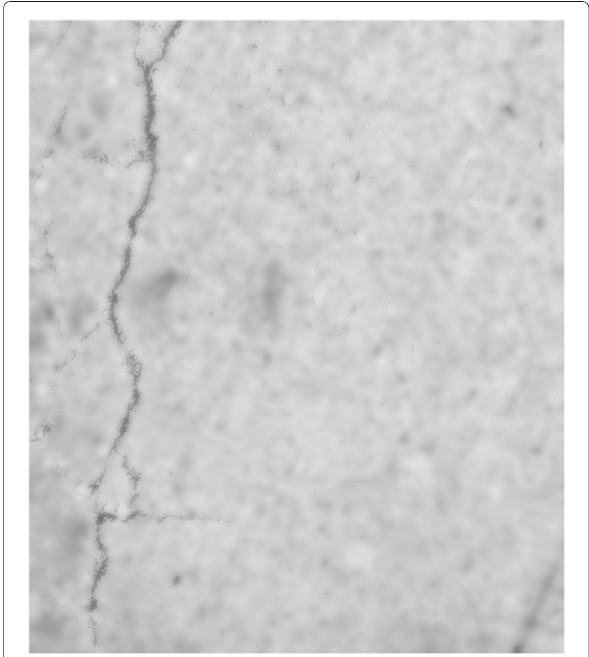
results, the best filter for this work is the closing